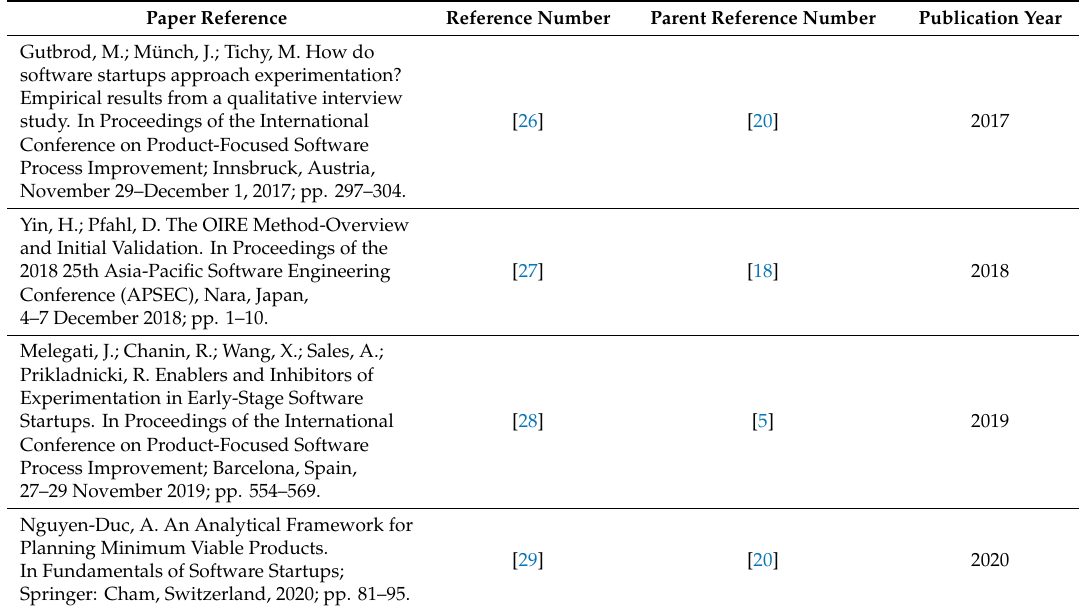
Table 3. Studies extracted for mapping (Forward